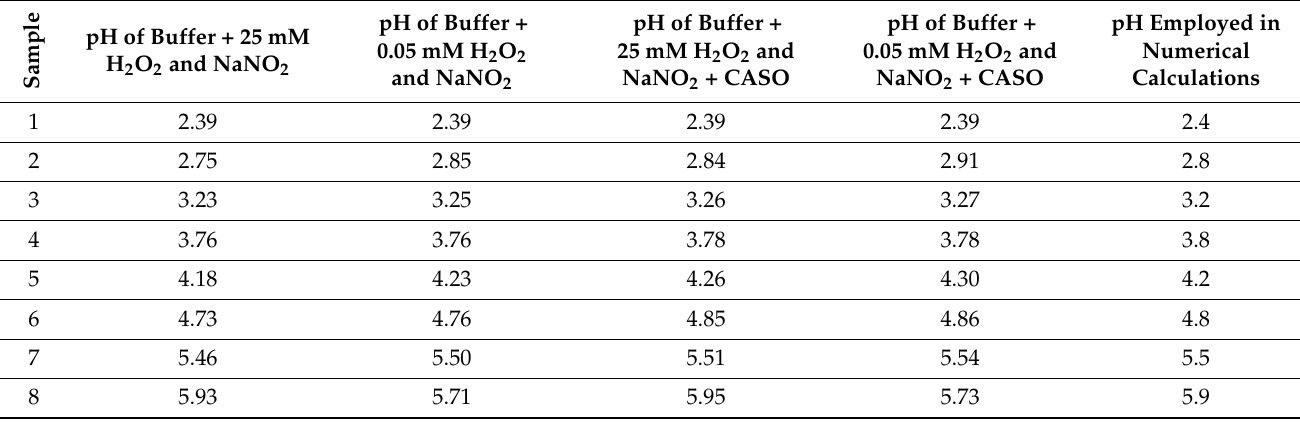
Table 1. pH values of various phosphate-citrate buffer solutions with the peroxynitrous acid-containing solutions after step 2 ( Buffer + XmM H 2 O 2 and NaNO 2 ) and after step 3 (addition of CASO broth to solution from step 2). e pH of Buffer + 25 p l m a S